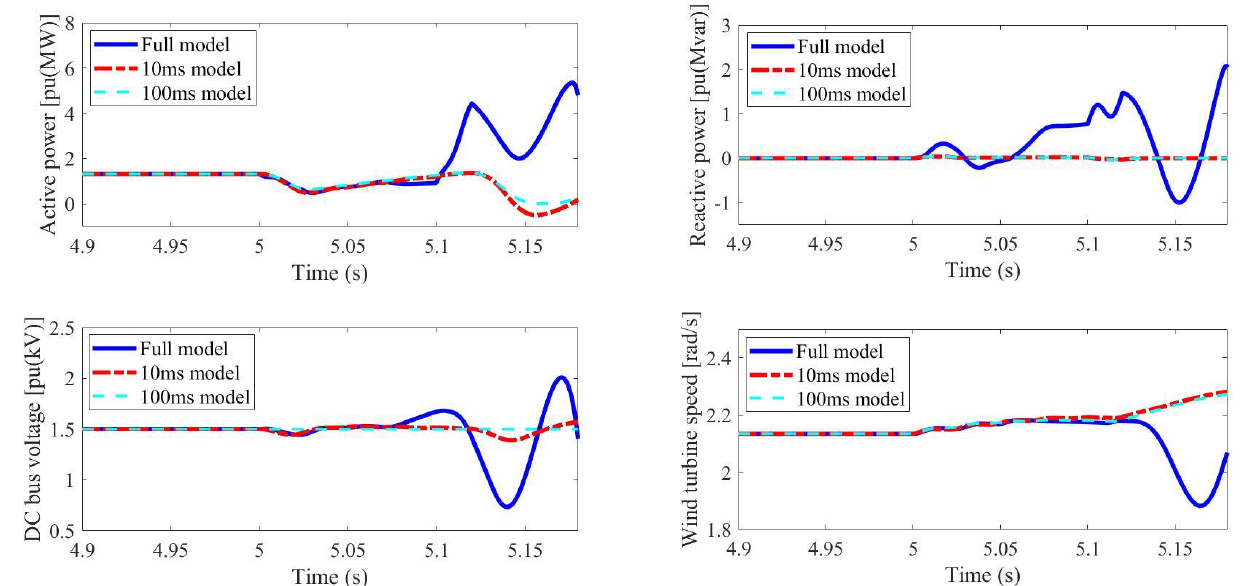
Figure 7. Grid fault: timescale model comparison.